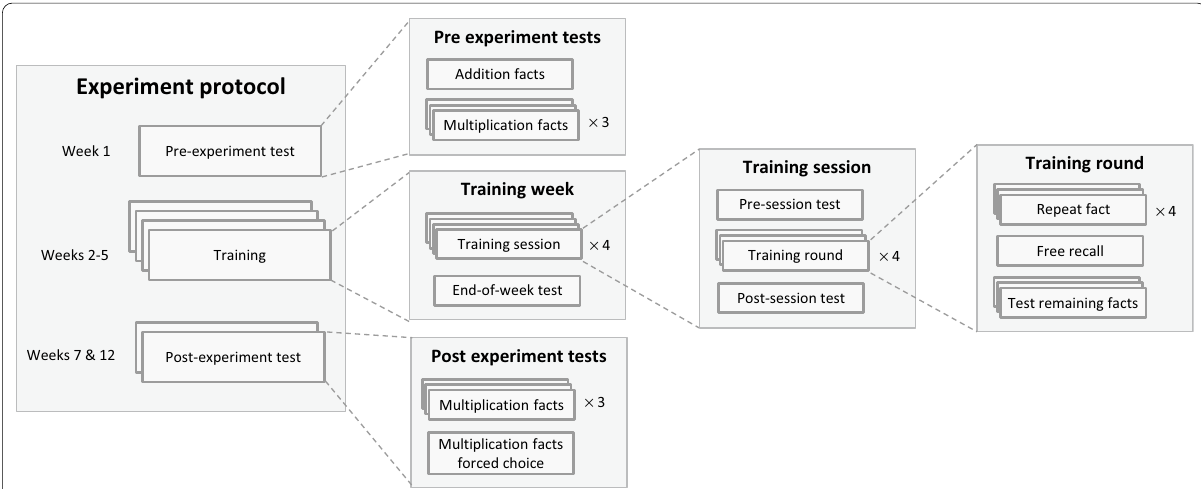
Fig. 1 The experiment protocol. The experiment included a pre‑experiment testing week (week 1), four training weeks (weeks 2–5), and two post‑experiment testing weeks (weeks 7 and 12). Each testing week included 3 sessions, each of which involved testing the child on each multiplication fact as an open question. The post‑experiment testing weeks also included a fourth session with a forced‑choice test. Each training week included 4 training sessions in which that week’s 4 facts were rehearsed, followed by a session that tested all facts trained in the present and previous weeks. A training session consisted of a pre‑session test (each of the week’s 4 facts tested once; a week’s first training session did not include a pre‑session test), 4 training rounds, and a post‑session test (each fact tested once). In a training round, the child first heard the 4 facts